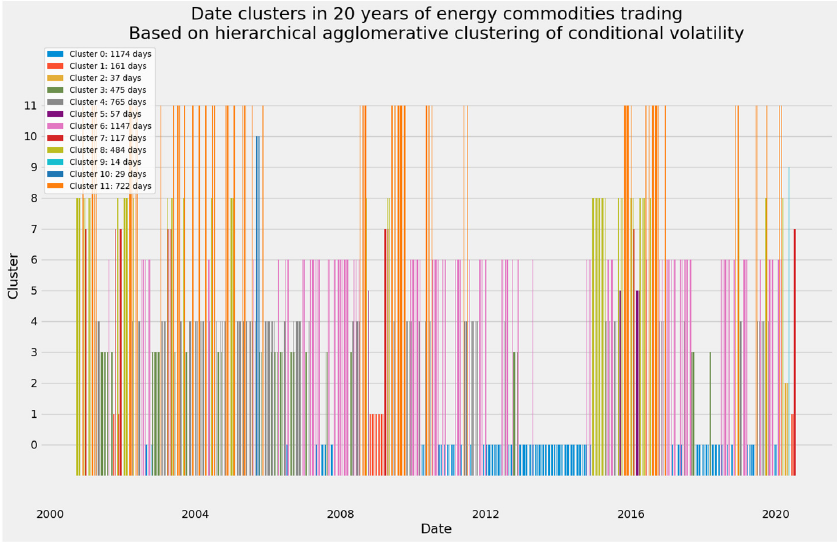
Figure 25. Hierarchical agglomerative clustering of energy-related markets—An ordered timeline.